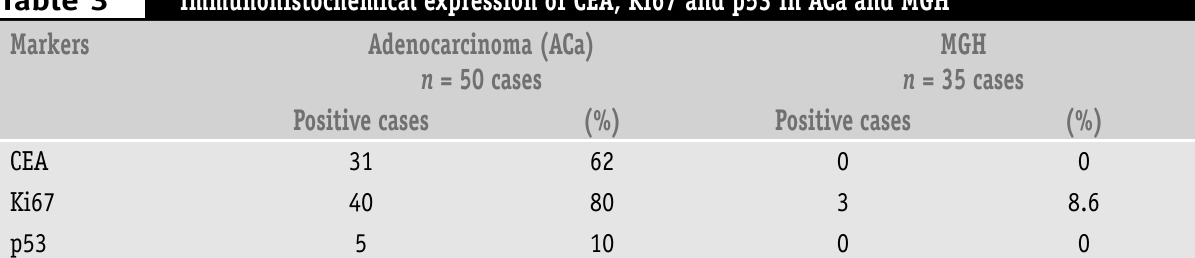
The data gathered in our study is similar to that of the most recent publications (3, 13) . The reduction in the number of cases of MGH related to the use of oral contraceptives might be explained by the modification of steroids and the considerable reduction of hormone dosage in the composition of the exogenous hormones currently